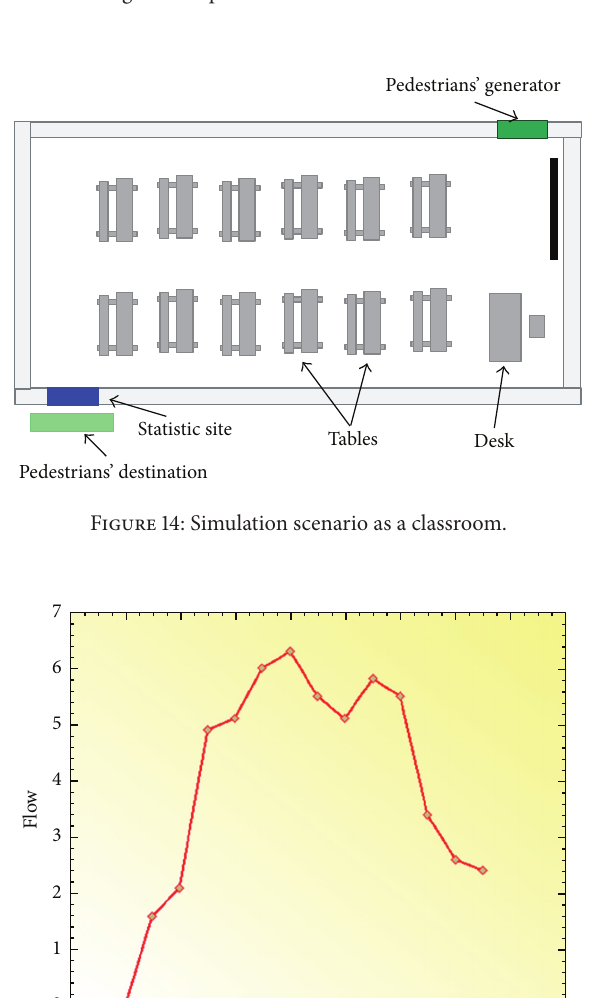
Figure 13: Dissemination of a shock wave of pedestrians moving in time according to their positions.